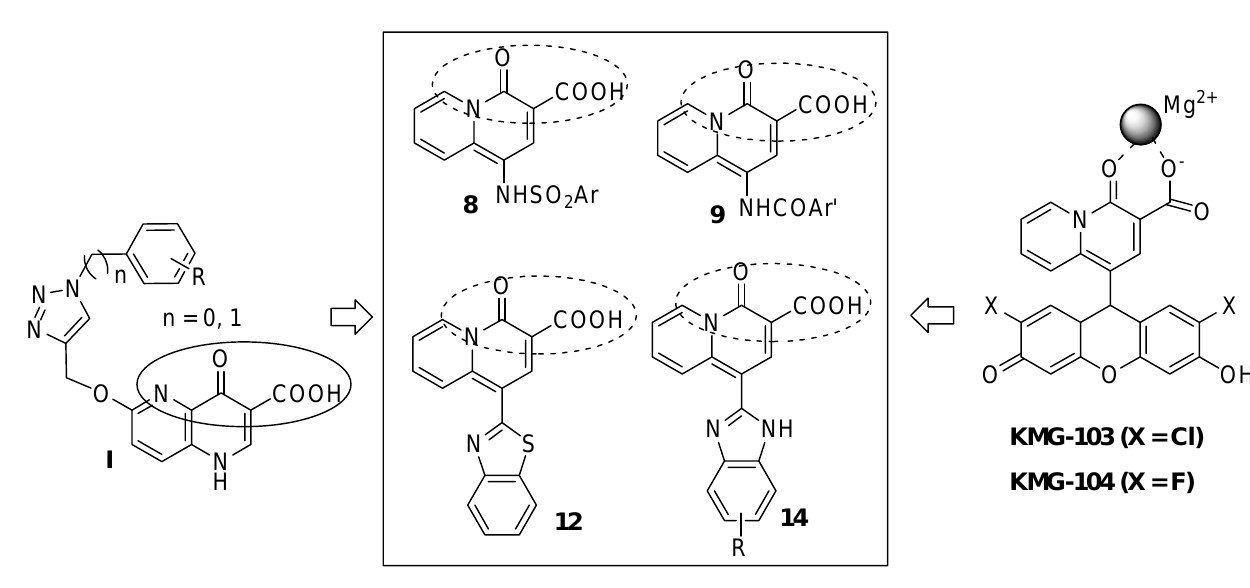
Figure 1 . The design of 4-oxo-quinolizine-3-carboxylic acid derivatives as potential HIV IN